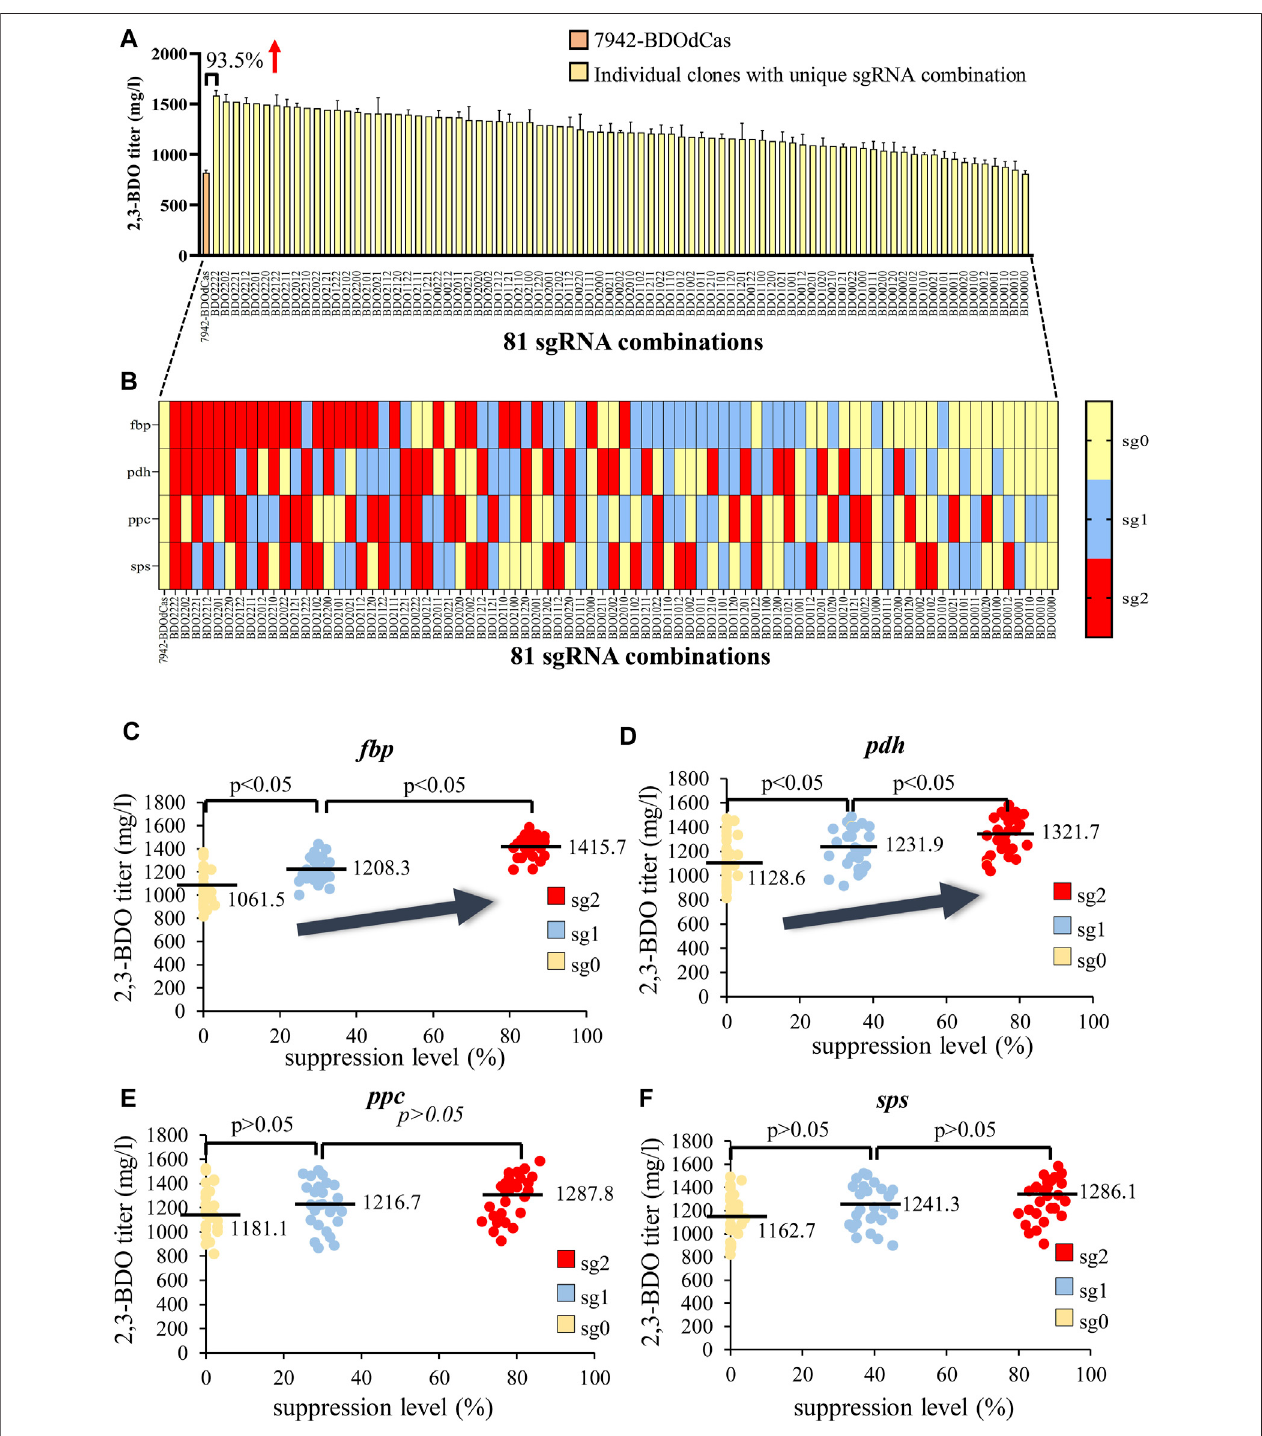
FIGURE 4 | Effects of combinatorial gene suppression on 2,3-BDO production. (A,B) Correlation between the extracellular 2,3-BDO titer and the 81 sgRNA combinations(alsosee SupplementaryTableS2 ).Allthe210clonesweresequencedanddesignatedbasedonthesgRNAcombination. (B) Illustrationofthetargeting site (sg0, sg1, or sg2) at each gene ( fbp , pdh , ppc , and sps ) and the designated sgRNA combination. For instance, BDO2222 indicates that the sgRNA targeted four genesatsg2.BDO2202indicatesthatthesgRNAtargeted fbp , pdh ,and sps atsg2and ppc withsg0. (C – F) Effectsofsuppressionof fbp (C) , pdh (D) , ppc (E), or sps (F) on the 2,3-BDO titer. The gene expression levels were measured by qRT-PCR, and suppression levels were calculated for each clone. The data represent the mean ± SD of at least three independent experiments and were statistically analyzed by one-way ANOVA. p < 0.05 was considered statistically signi fi cant.